Question: Write a descriptive caption for this figure.
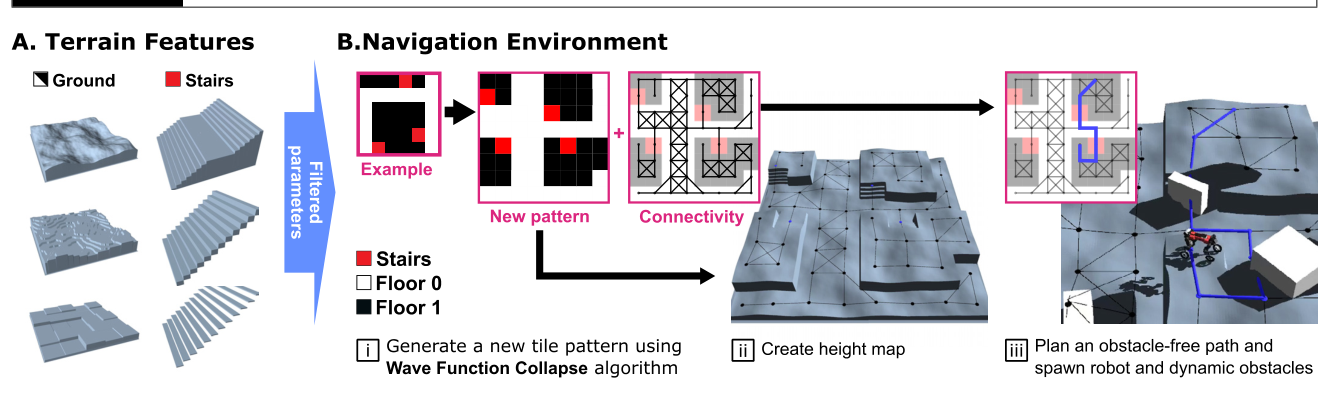
Answer: Procedural generation of the navigation world. (A) Filtered parameterized terrain during low-level policy training. (B-i) Generating new tile maps and connectivity graph using the Wave Function Collapse algorithm. (B-ii) Created height map terrain with filtered floor features and stair parameters. (B-iii) Randomly generated navigation path between two nodes provides waypoints during training. Dynamic obstacles (white boxes) are added randomly.